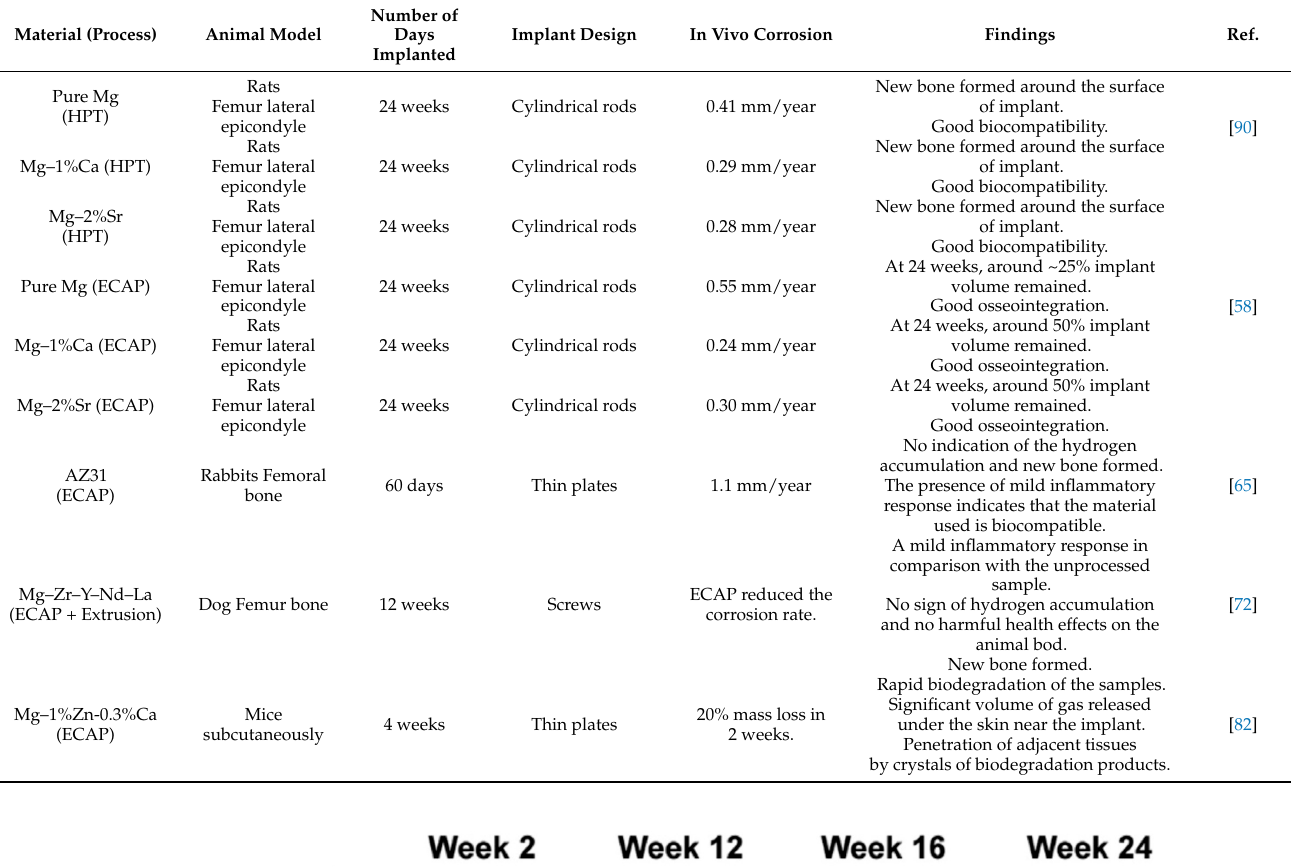
Table 3. Summary of in vivo tests carried out in Mg and Mg alloys processed via SPD.